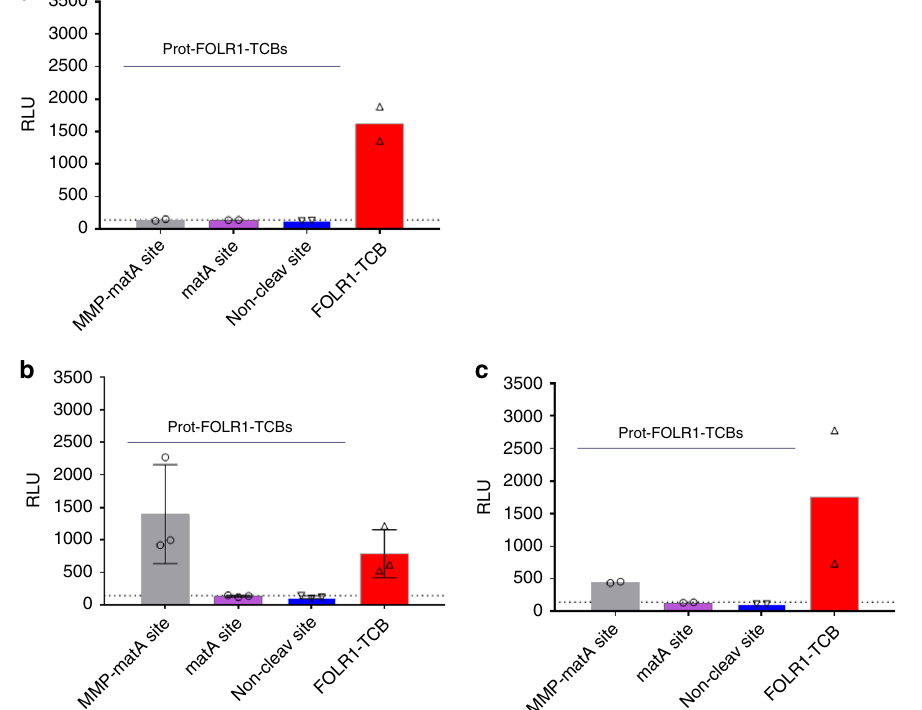
Fig. 7 Prot-FOLR1-TCB can be activated by patient-derived ovary cancer explants. Jurkat NFAT reporter assay was used to analyze activation of Prot- FOLR1-TCB (matA or MMP-matA linker) ex vivo by undigested human tumor explants. a Benign tumor of the ovary. b Cancer of the ovary. c Cancer of the ovary. Explants were mechanically cut and then incubated with TCBs and analyzed for CD3 activation using Jurkat NFAT cells. Jurkat NFAT activation is measured in relative luminescence units (RLU). Each symbol indicates the value measured for one biological sample incubated with Jurkat NFAT cells and Prot-FOLR1-TCB MMP-matA site (gray bar), matA site (purple bar), noncleavable site (blue bar) or FOLR1-TCB (red bar). a Each data point shows the mean of technical duplicates measured for one well ( n = 2 biological replicates). b Each data point shows the value measured for one well ( n = 3 biological replicates). Standard deviation is indicated by error bars. c Each data point shows the mean of technical duplicates measured for one well ( n = 2 biological replicates). The dotted lines indicate luminescence for Jurkat NFAT-cells incubated with tumor samples but without any TCB.